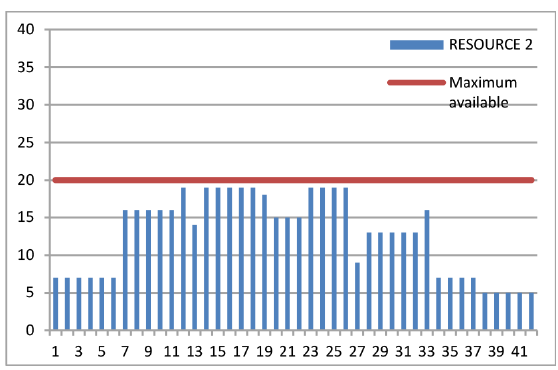
Figure 18. Daily usage of resource 2 throughout the calendar of the project (before using the method)-Experiment 1